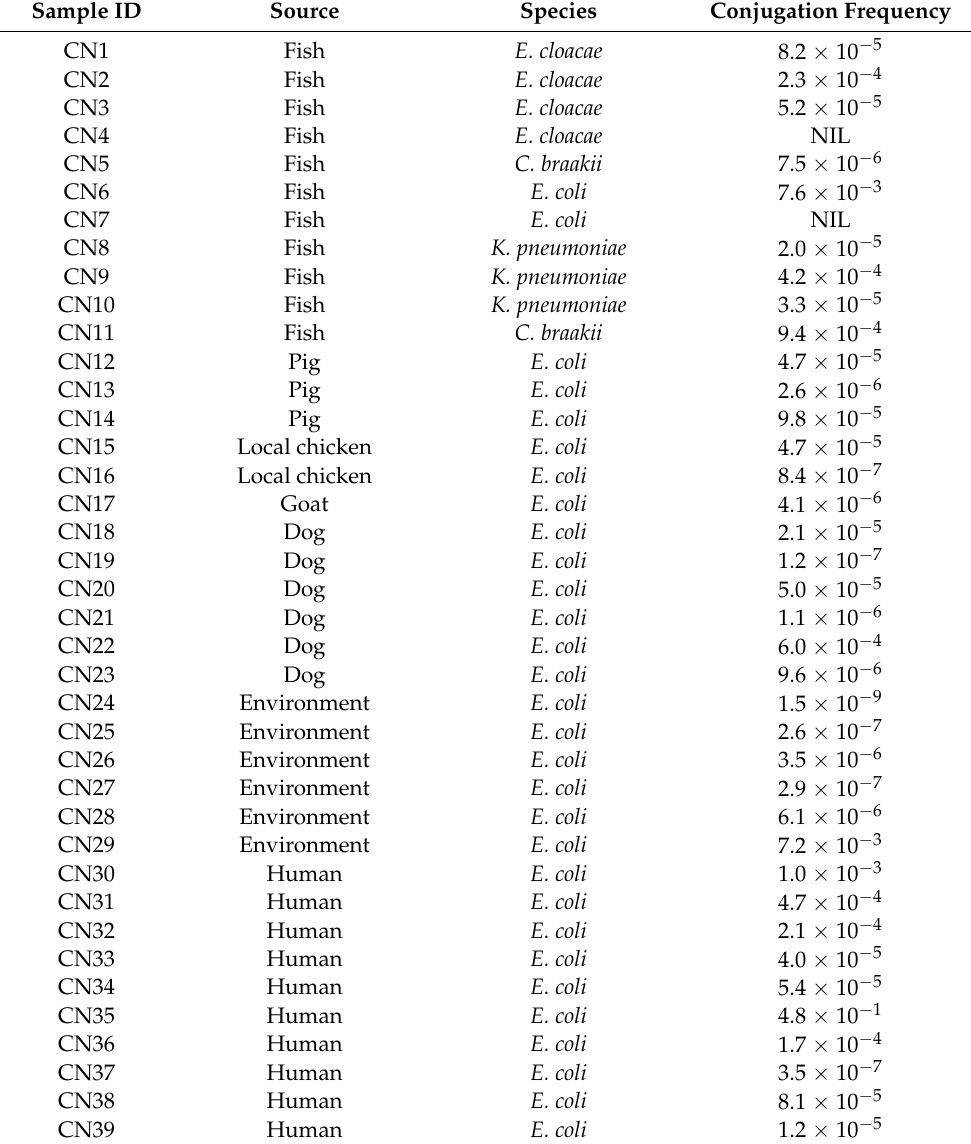
Table 2. Conjugation efficiency of human, animal and environment donor